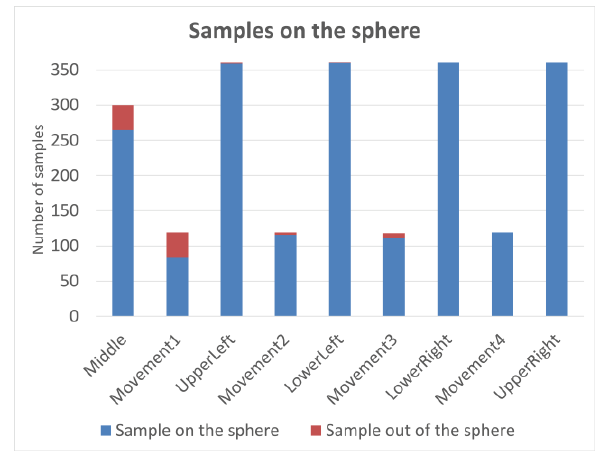
Fig. 6. Evaluation of the data validity. Red color corresponds to the data samples where gaze was not recorded on the target